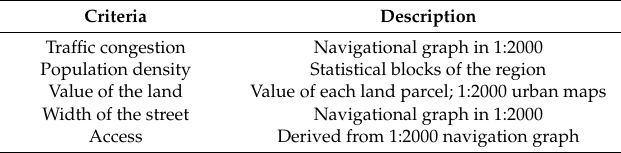
Table 1. Data for the main criteria.